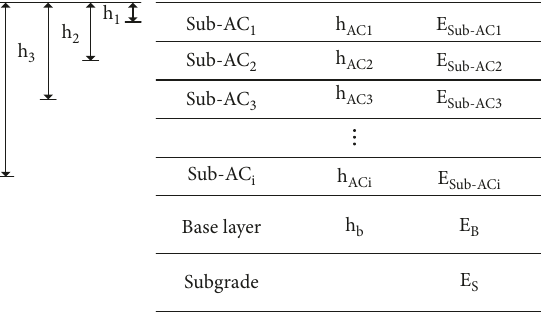
Figure 6: Typical pavement structure.